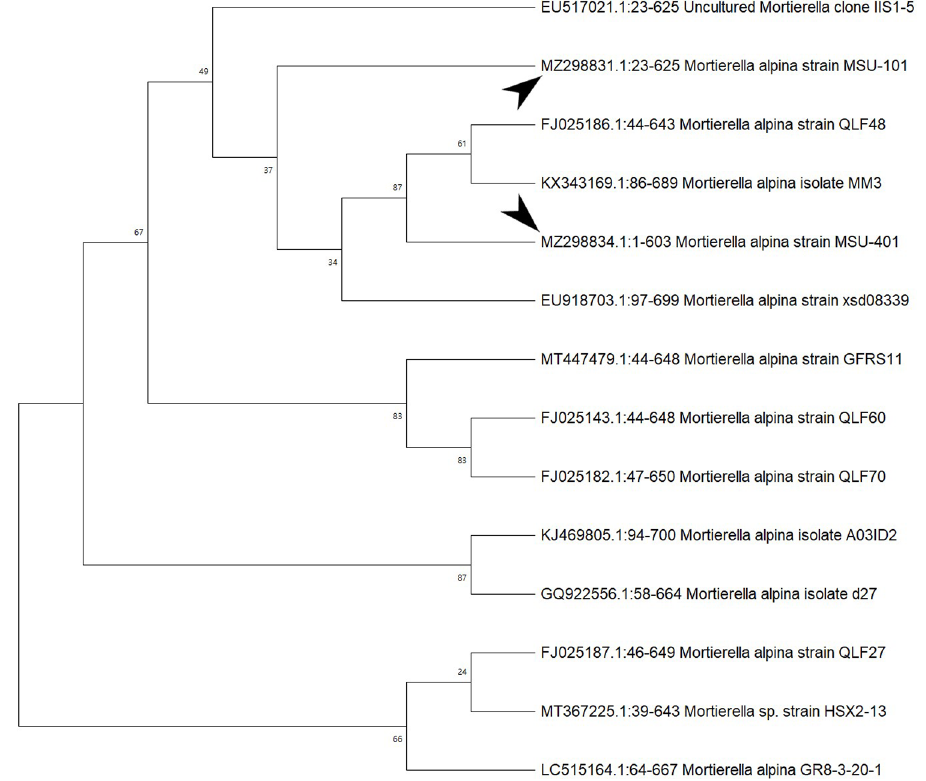
Figure 3. Neighbour joining method based phylogenetic tree from internal transcribed spacer conserved sequences of isolates MSU-101 and MSU-401. Bootstrap support values are indicated at the